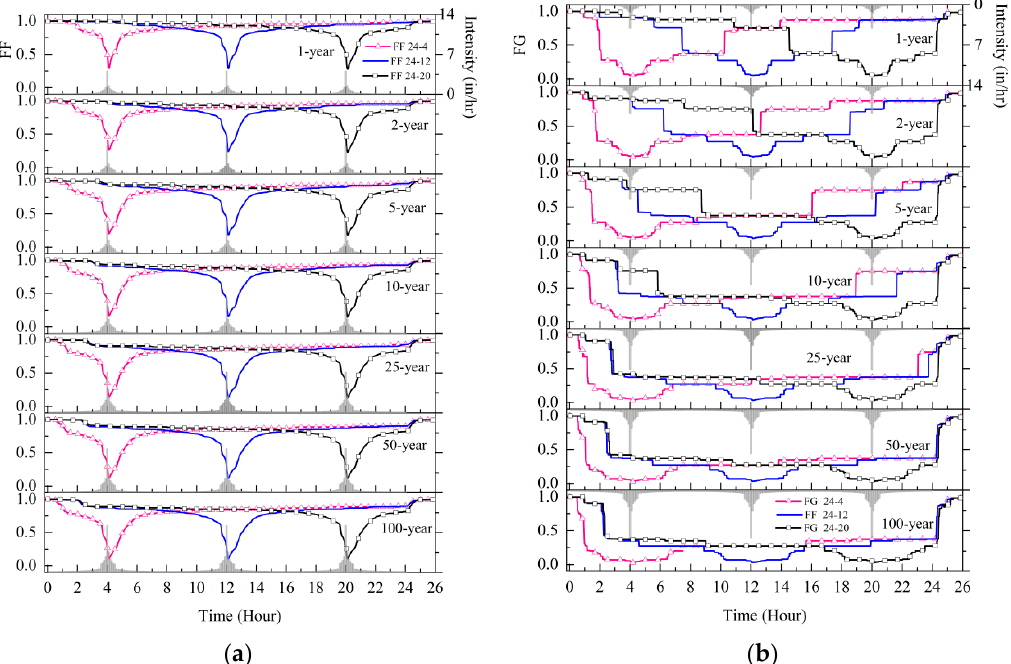
Figure 4. The variations in the values of the fractions of FF and FG in different rainfall patterns. ( a ) FF, ( b ) FG. The grey histogram is the rainfall distribution, the pink curve with triangles is the 24-4 event, the blue line is the 24-12 event, and the black line with squares displays the 24-20